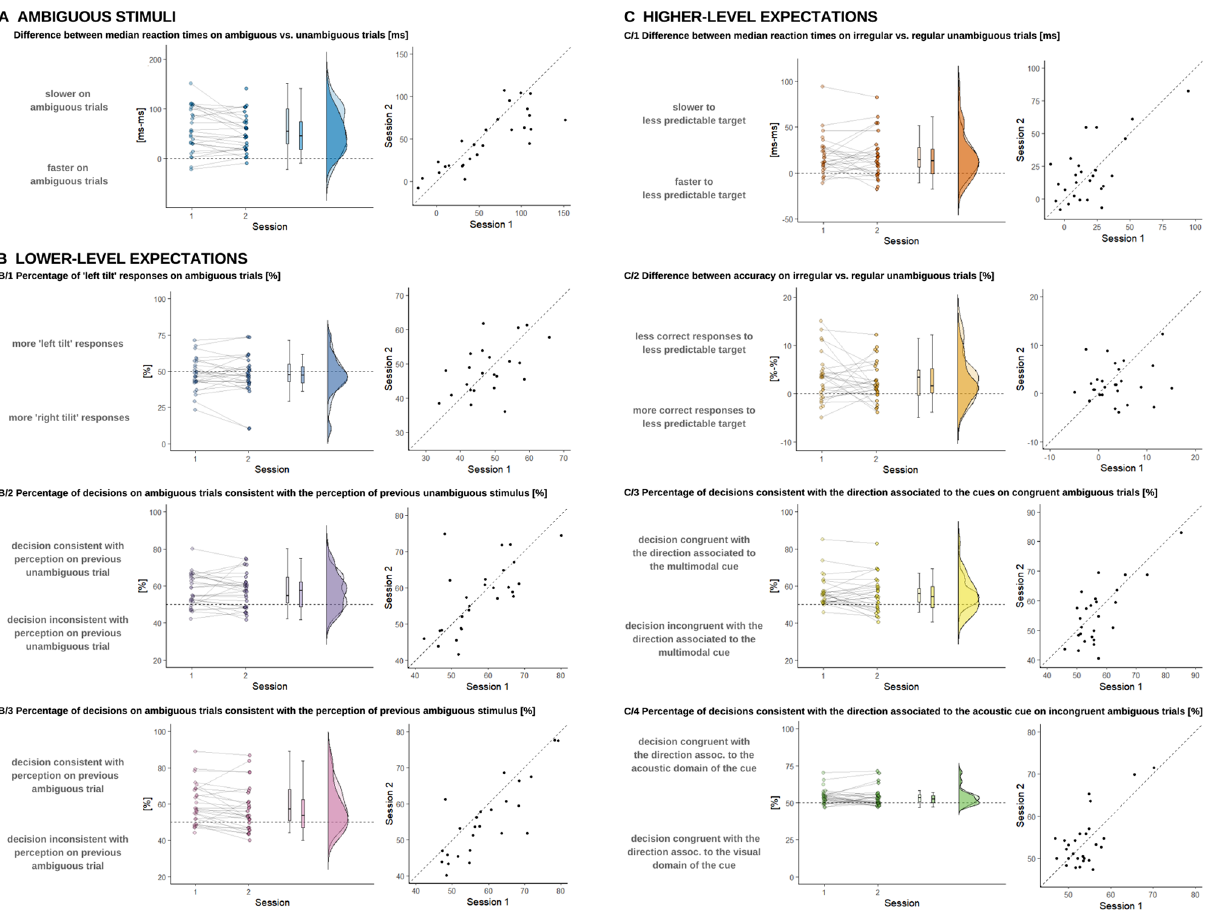
Figure 2. Processing of ambiguous stimuli and the influence of lower- and higher-level expectations. Within each panel of the figure, on the left side, dots represent participants, and the values from each session are connected along the x axis, a boxplot (median, 50% CI) is shown, and the distribution for each session can be seen. While on the right side of the panels, each dot represents a participant’s performance in session 1 and 2 on the x and the y axis, respectively. Dashed line indicates the hypothetical perfect correlation. Please find test–retest statistics in Table 1. ( A ) Processing of ambiguous stimuli takes more time. On the y axis, median reaction times differences on unambiguous- ambiguous trials (the target stimuli was made unambiguous with motion streaks). If there was no difference between these conditions, dots should be around 0 ms (level shown with dashed line). Test–retest stability was high and general motor learning was also observed. ( B ) Effects of lower-level priors captured by response tendency on ambiguous trials. [B/1] Response tendency in ambiguity. Along the y axis, we present the percentage of ‘left’ decisions in ambiguity. If there were no tendency, participants should perform around chance level (50%, shown with dashed line). Test–retest stability was high. [B/2] Sensory priming effect in ambiguity. Along the y axis, we present the percent of decisions consistent with the previous decision made in unambiguity. If there were no sensory priming, participants should perform around chance level (50%, shown with dashed line). Test–retest stability was high. [B/3] Effect of perceptual priming in ambiguity. Along the y axis, we present the percentage of decisions consistent with the previous decision made in ambiguity. If there were no perceptual priming, participants should perform around chance level (50%, shown with dashed line). Test–retest stability was high. ( C ) Effects of higher-level priors captured by reaction time and accuracy on unambiguous trials and by response tendency on ambiguous trials. [C/1] Slowing down to unexpected (vs. expected) targets. On the y axis, median reaction times differences between irregular—regular unambiguous trials (when cues were followed by less vs more predictable tilting illusion according to the probabilistic rule). If there was no difference between these conditions, dots should lie around 0 ms (level shown with dashed line). Test–retest stability was high and motor learning was indicated by shorter reaction times in session 2. [C/2] Decreased accuracy to unexpected vs. expected targets. On the y axis, the difference between the % of correct responses to irregular— regular unambiguous stimuli are presented. If there was no difference between these conditions, dots should be around 0 ms (level shown with dashed line). Test–retest stability was poor, probably due to a ceiling effect. [C/3] Cues influence responses to ambiguous targets. Along the y axis, we present the percentage of decisions consistent with the direction associated with the cues in ambiguity when the cues were congruent. If there were no effect of associative learning on perceptual decisions, participants should perform around chance level (50%, shown with dashed line). Test–retest stability was high. [C/4] Auditory cues dominantly influence responses to ambiguous targets. Along the y axis, we present the percentage of decisions consistent with the direction associated to the acoustic cue in ambiguity after incongruent cues (where the acoustic and visual cues were associated with different directions). If there were no dominance of any modality, participants should perform around chance level (50%, shown with dashed line). Test– retest stability was